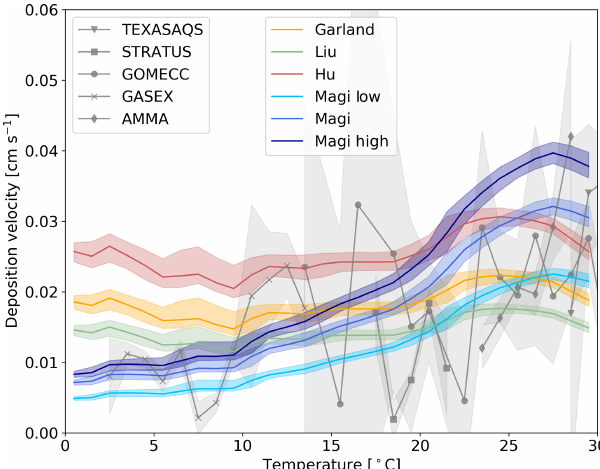
Figure 6. The response of deposition velocity to different labora- tory measurements of k . Three are constant with respect to temper- ature (Garland et al., 1980; Liu et al., 2001; Hu et al., 1995) and the temperature-dependent parameterization of Magi et al. (1997), with two additional cases of k based on the error range of the Magi et al. (1997) measurements (shown in Eqs. 13 and 12). Each function is produced from global values averaged into 1K temperature bins, with the shaded region representing the 25th to 75th